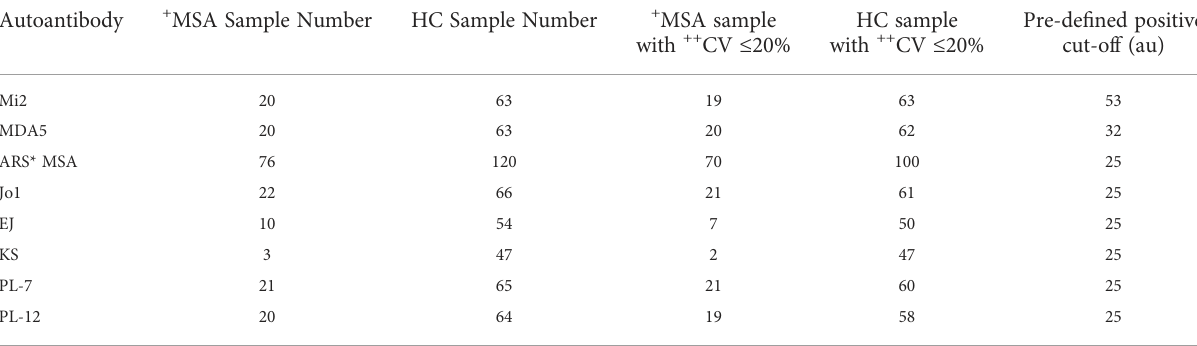
*Aminoacyl tRNA synthetase myositis speci fi c antibodies combined (Jo1, EJ, KS, PL7, PL12). + Myositis speci fi c antibody